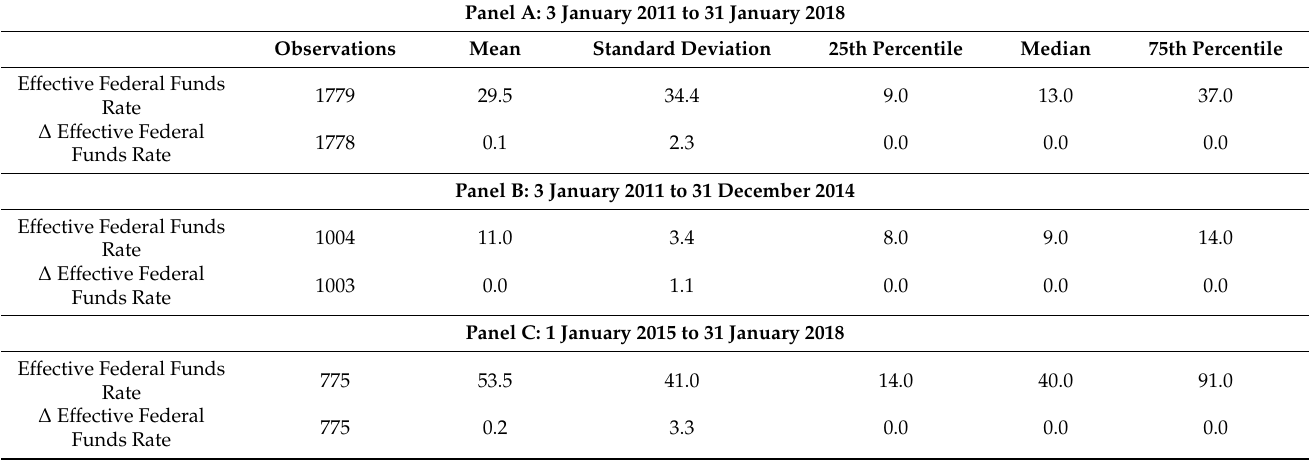
Table 1. Summary